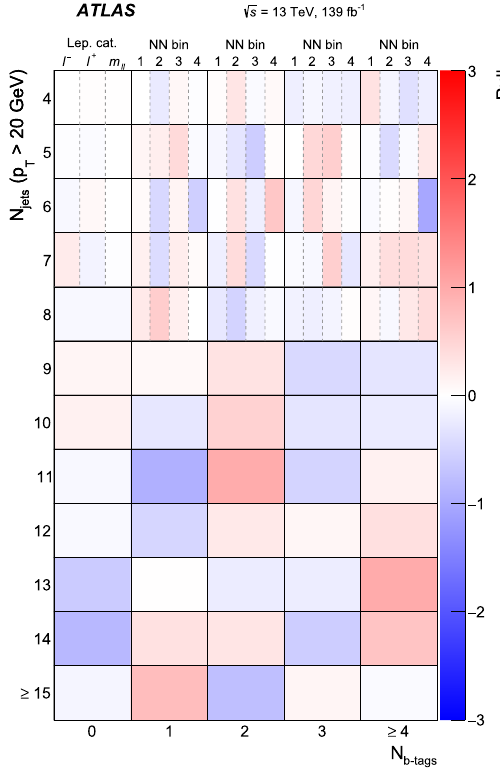
Fig. 7 The observed pulls in all the regions considered in the EWK analysis, in the 1 (cid:3) category (left) and the 2 (cid:3) sc category (right). The pull is defined as the difference between the observed number of events and the total expected number of events determined by the fit divided by the